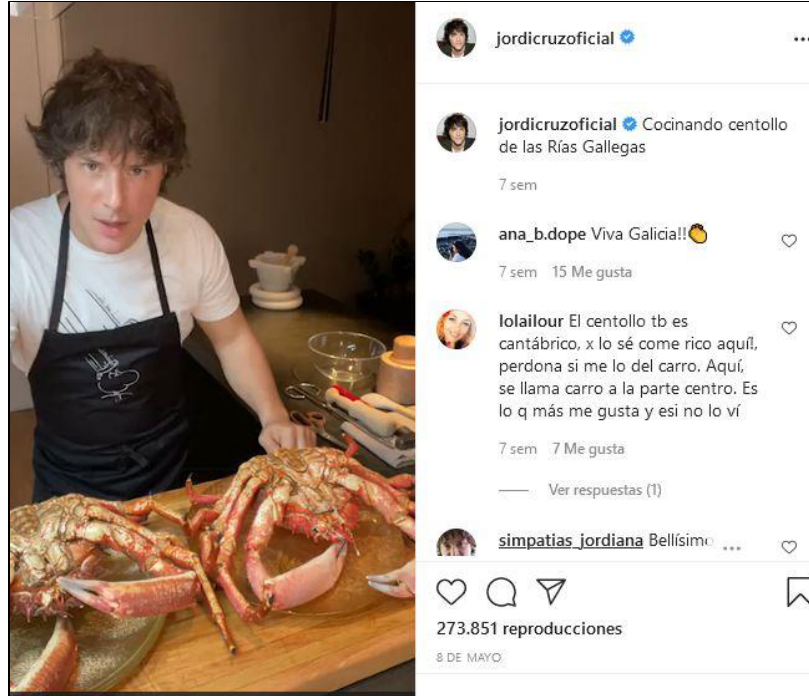
Figure 1 . Image of the Instagram of the chef Jordi Cruz. Figure A1. Image of the Instagram of the chef Jordi Cruz.